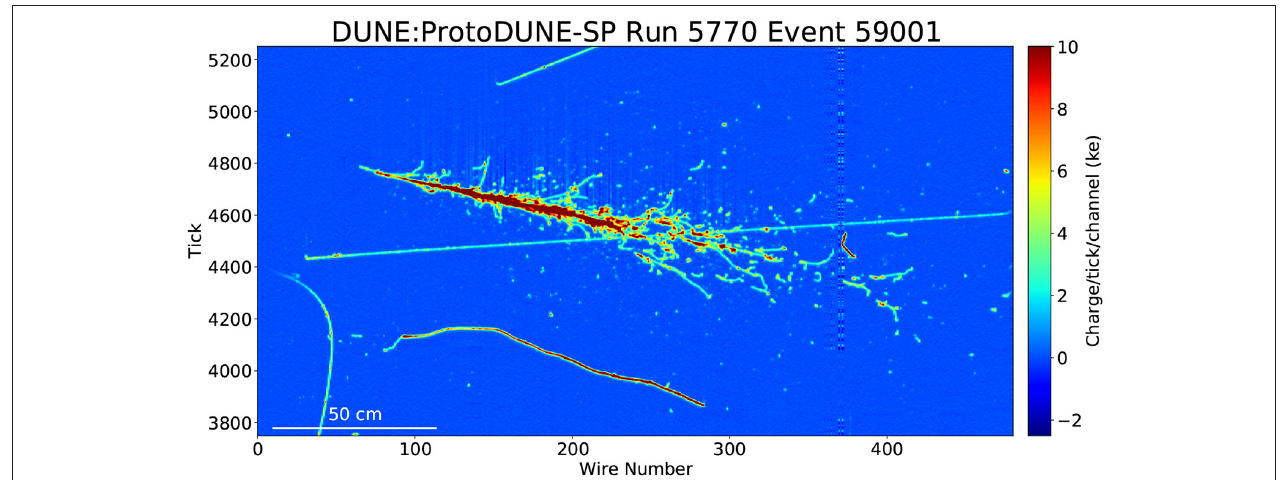
FIGURE 4 | A 6GeV/c electron event in the ProtoDUNE detector. The x-axis shows the wire number. The y-axis shows the time tick in the unit of 0.5 µ s . The color scale represents the charge